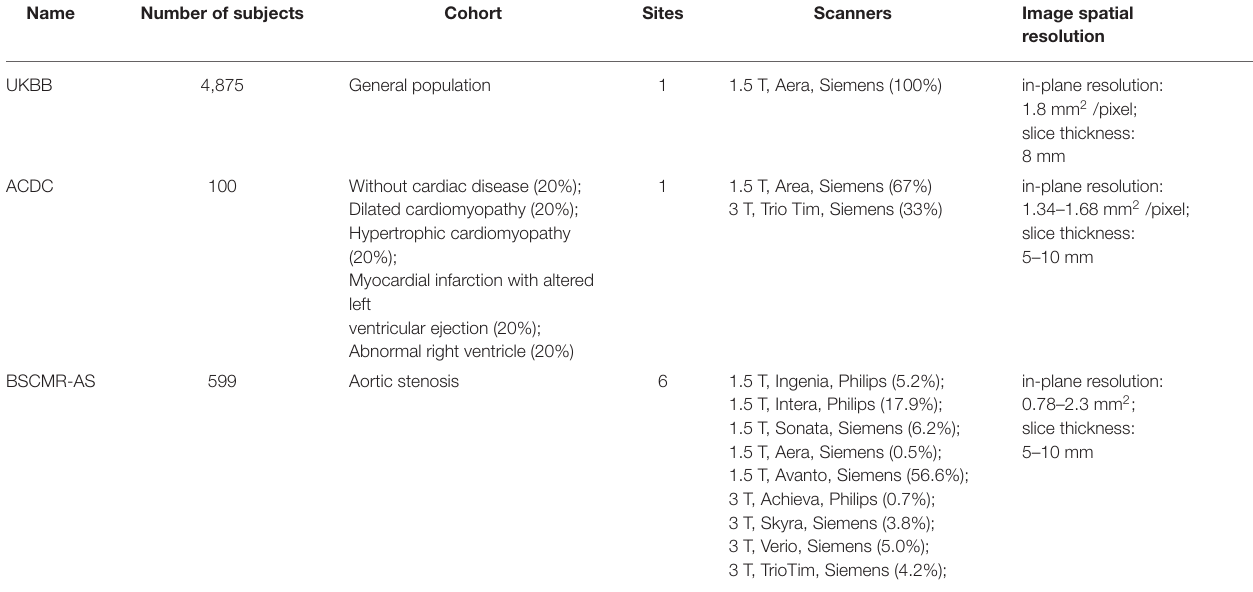
TABLE 2 | General descriptions of the three